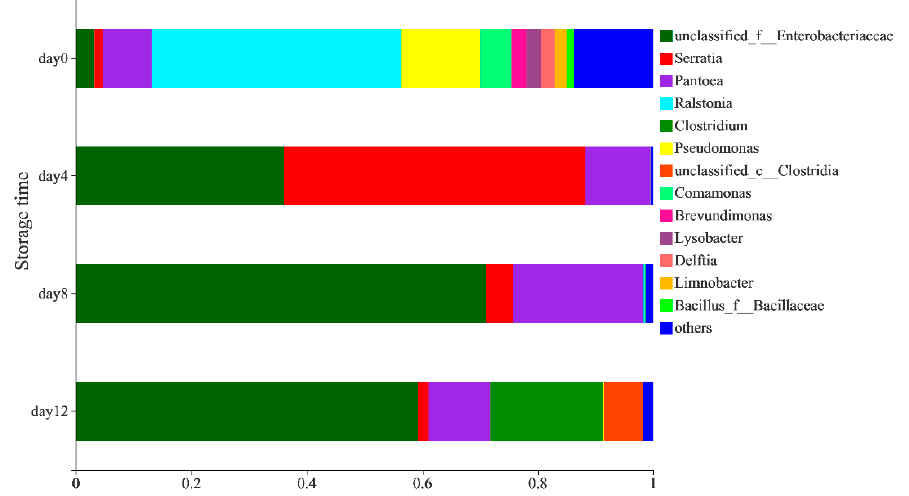
Figure 2. The distribution of bacteria on a genus-level during the storage of vacuum-packaged peeled potatoes.